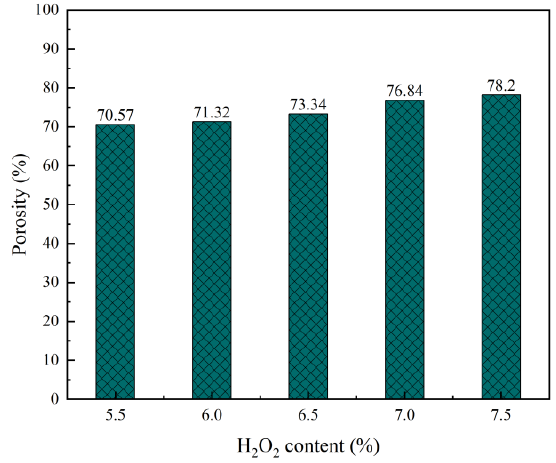
Figure 6. Effect of H 2 O 2 content on porosity of foam concrete.